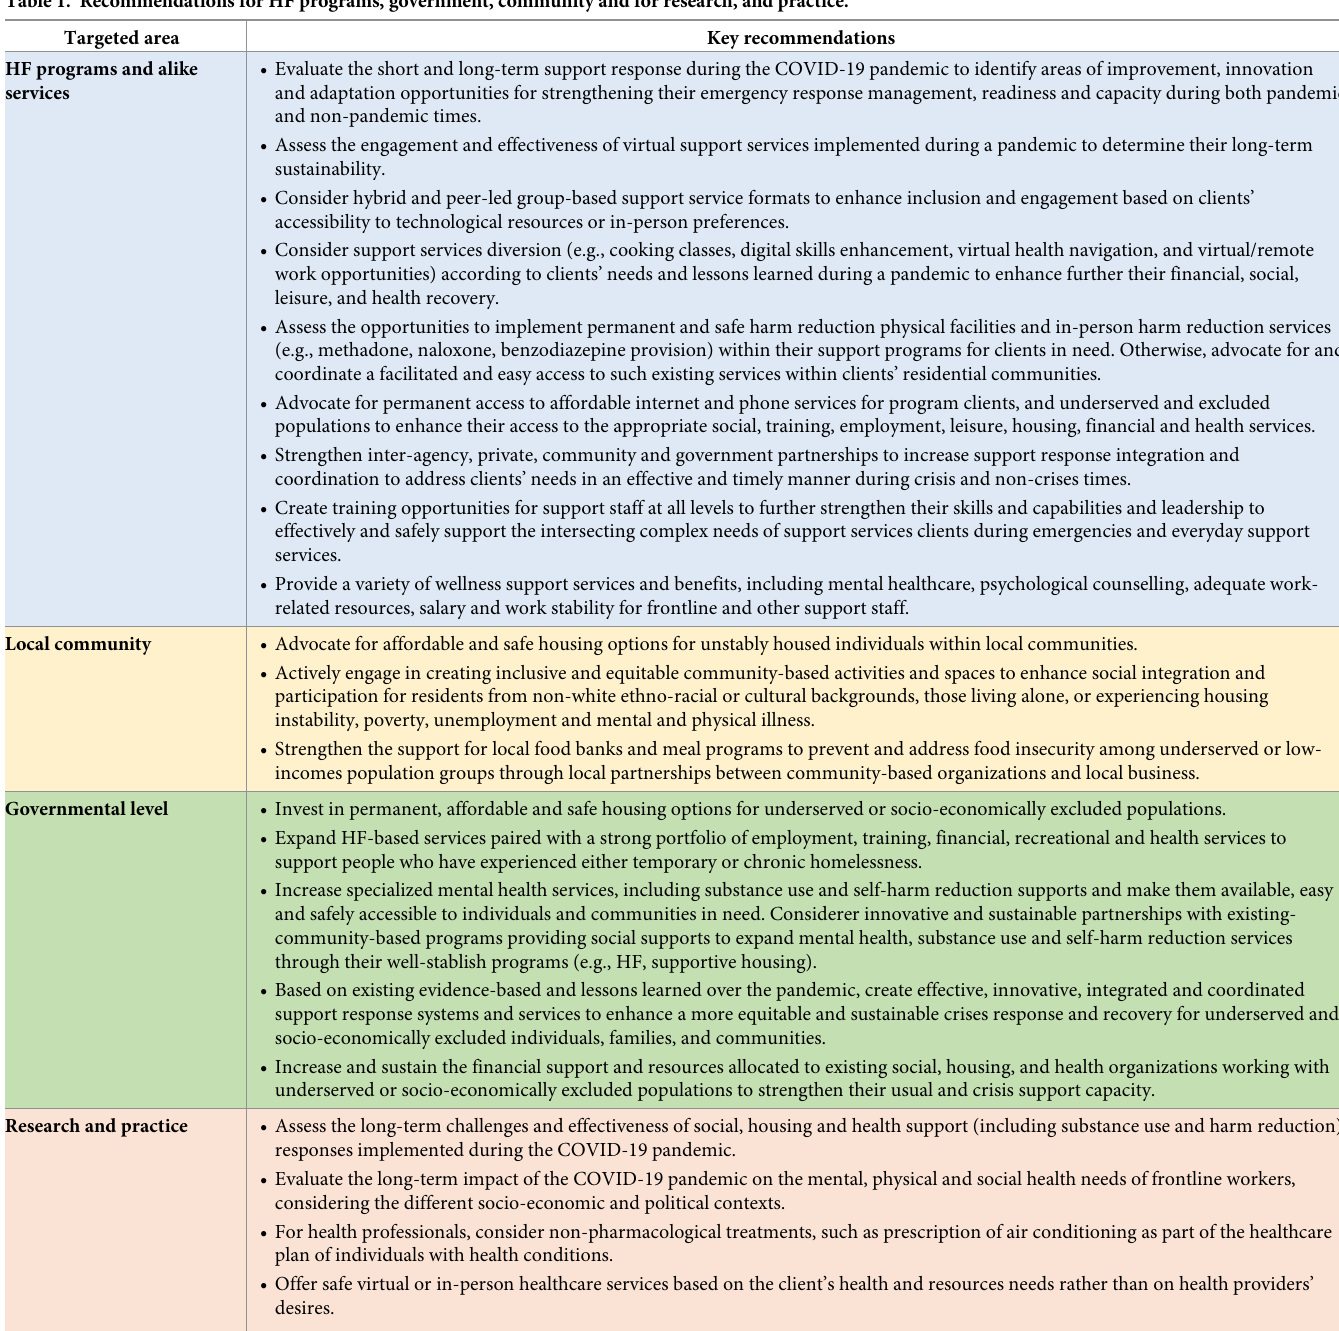
Table 1. Recommendations for HF programs, government, community and for research, and practice. Targeted